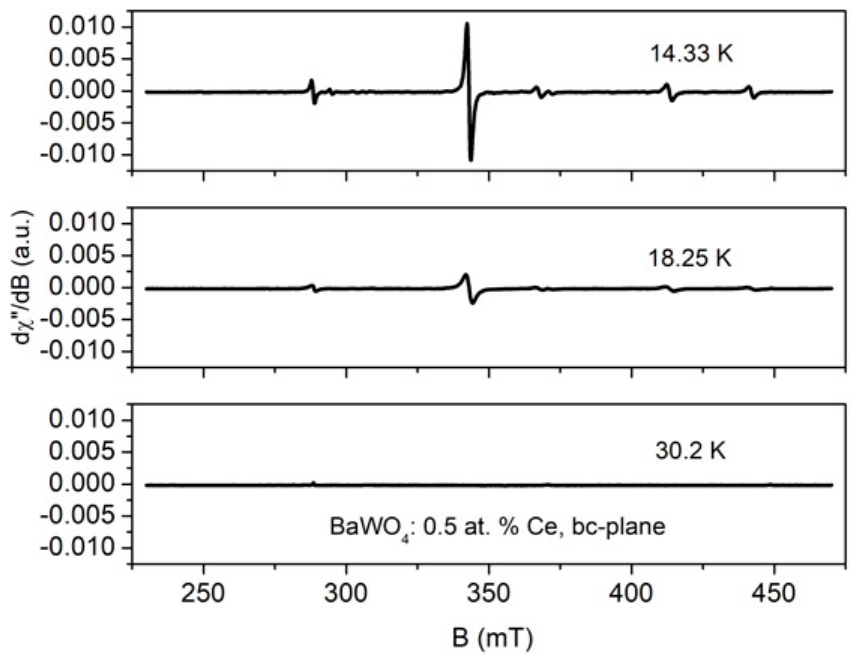
Figure 2. EPR spectra of the BaWO 4 : 0.5% at. Ce recorded in different temperatures [11].